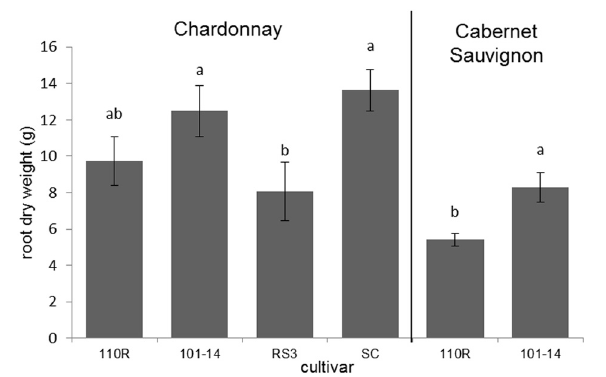
FIGURE 3 | Root dry weights of Chardonnay or Cabernet Sauvignon grafted to select rootstock cultivars. Letters represent pairwise differences by LSD for each scion. Bars indicate